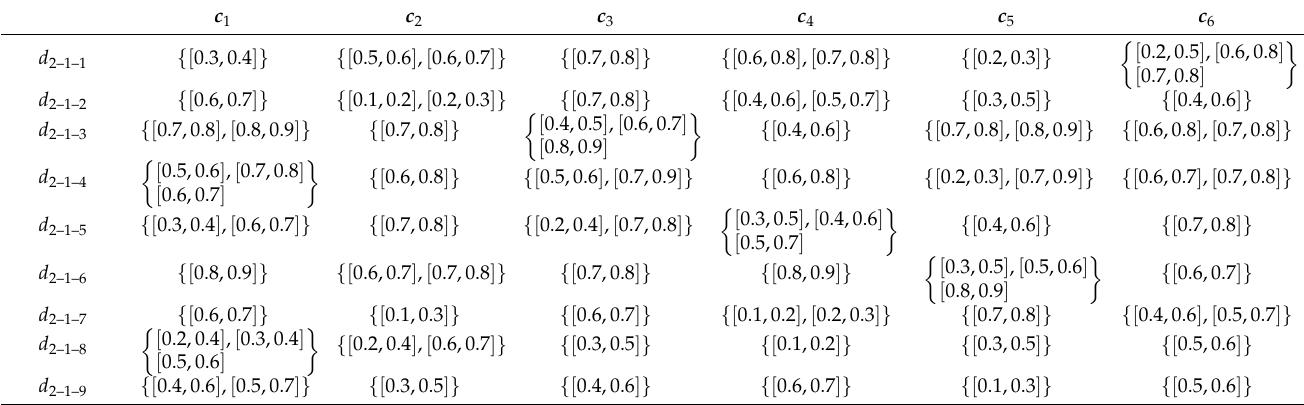
Table A13. Scoring matrix of subjective satisfaction d 2–1